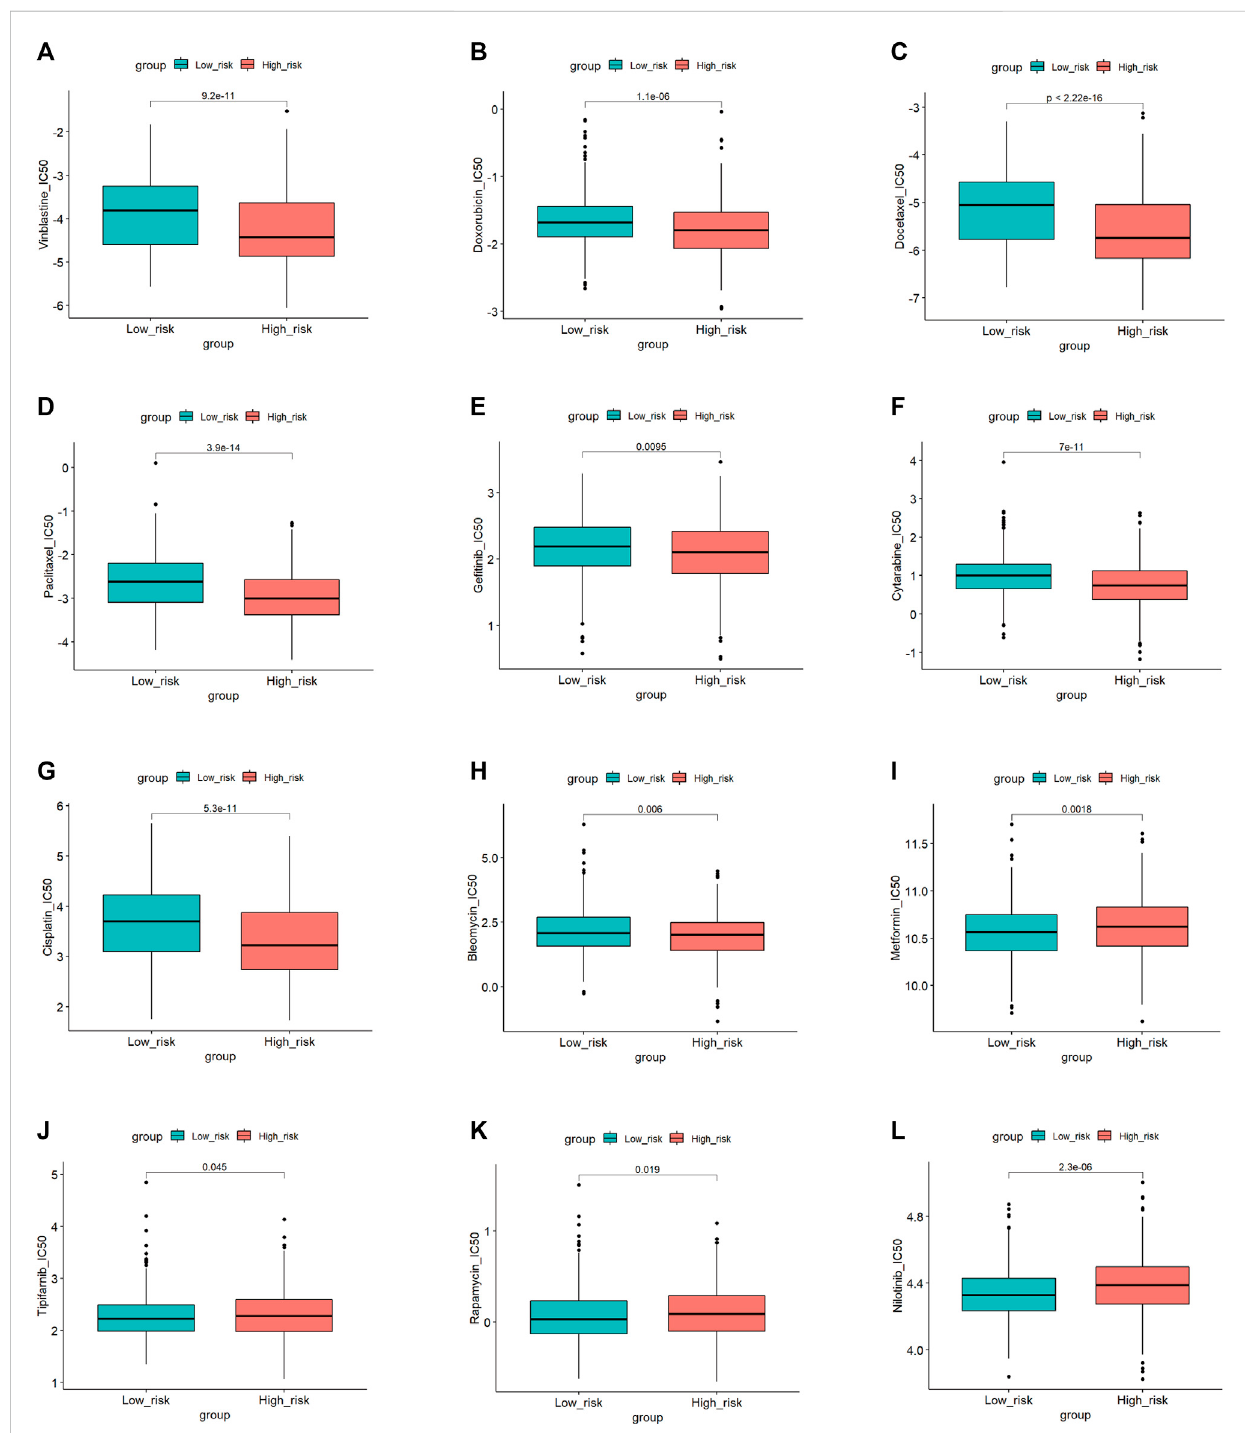
FIGURE 9 Drugs sensitivity in the high and low-risk